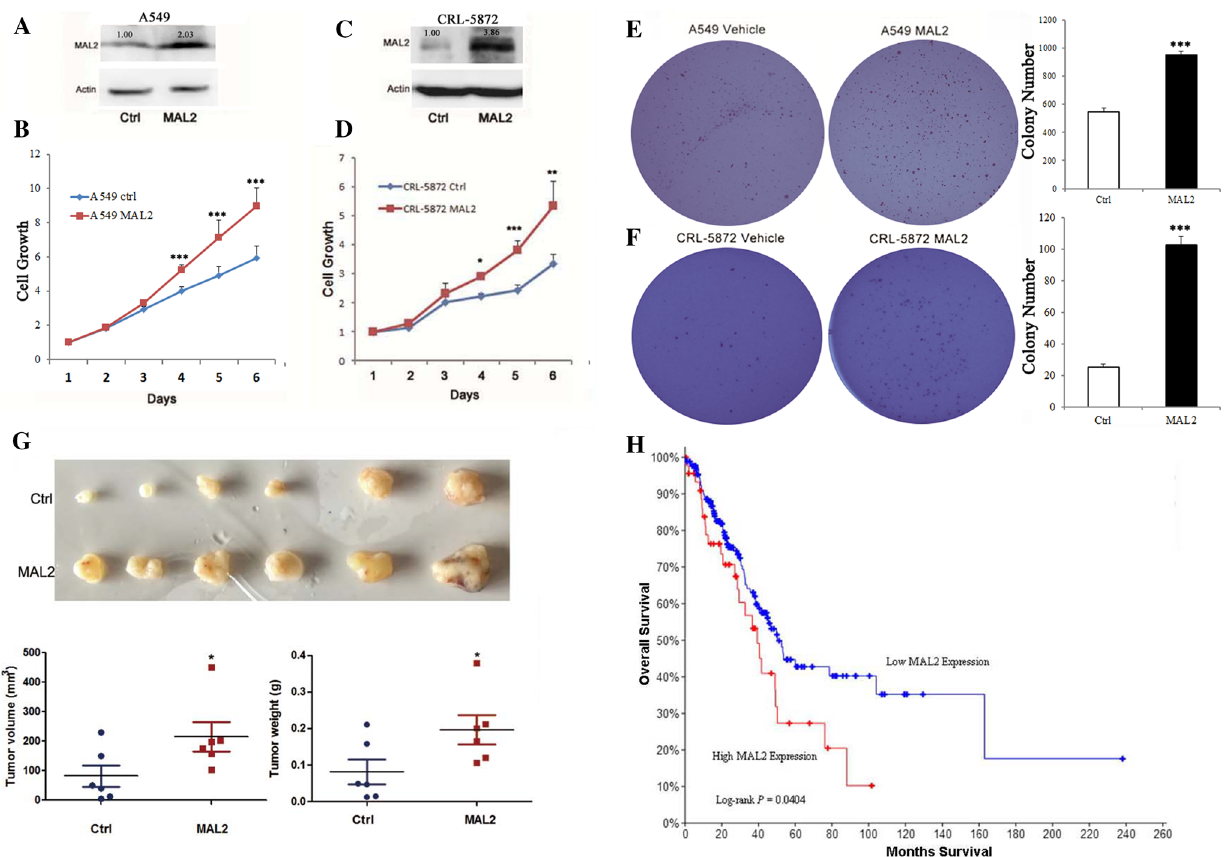
Fig. 2 MAL2 promotes NSCLC progression. A , C Western Blot analysis of MAL2 expression in lung cancer cell lines with or without MAL2 overexpression. Actin was used as loading control. B , D A549 and CRL-5872 expressing vector control or over-expressing MAL2 were assayed for cell proliferation. The values represent the average ± SEM determined from at least three independent experiments. E , F MAL2 promoted anchorage-independent growth of A549 and CRL-5872 cells in soft agar assay. Three independent experiments were performed. G MAL2 promoted tumor growth in A549 xenograft assay. Nude mice were injected with lentivirus-GFP or lentivirus-MAL2 A549 cells and photos of xenograft tumors, tumor volume and tumor weight were shown. N = 6 mice for each group. H Kaplan–Meier curve of overall sur- vival of non-small cell lung cancer patients analyzed for MAL2 expression in the 512-patient-TCGA cohort. The blue line shows the overall survival of patients with low MAL2 expression, the red line shows patients with high expression of